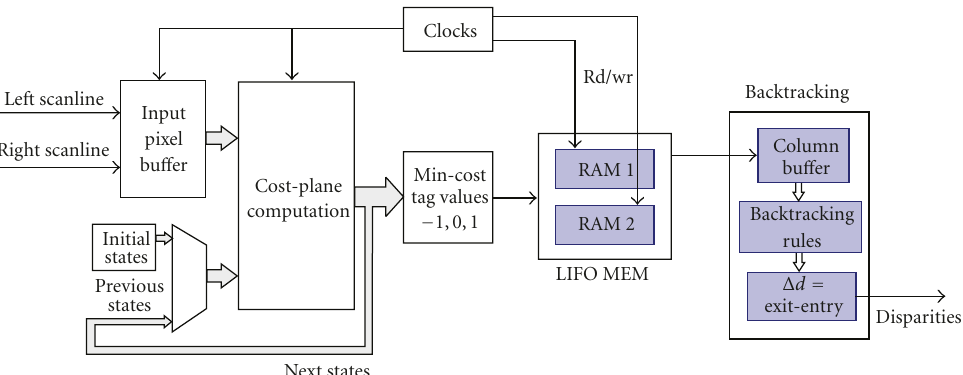
Figure 10: Block diagram of the stereo system based on dynamic programming.